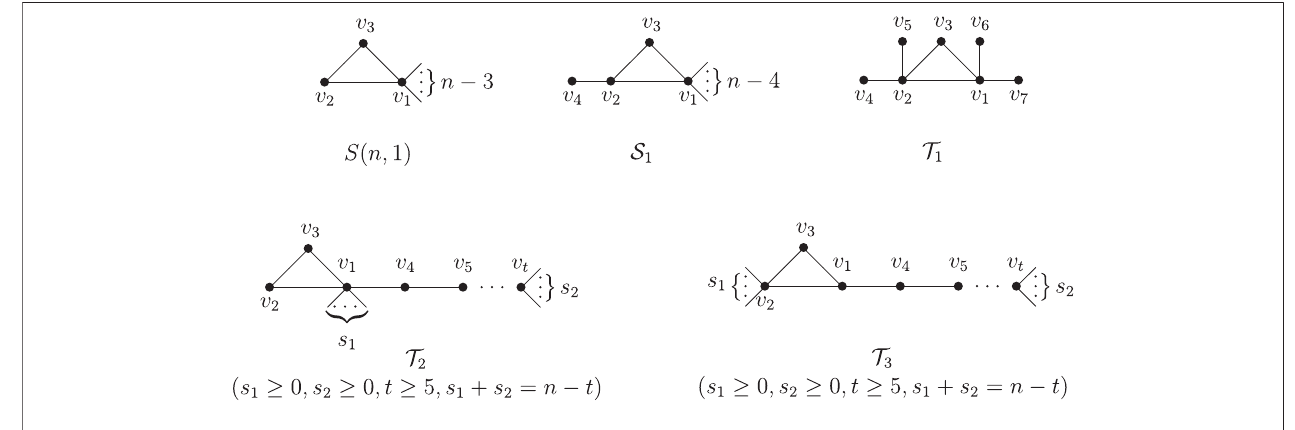
FIGURE 1 | Graphs S ( n , 1 ) , S 1 , T 1 , T 2 , and T 3 .